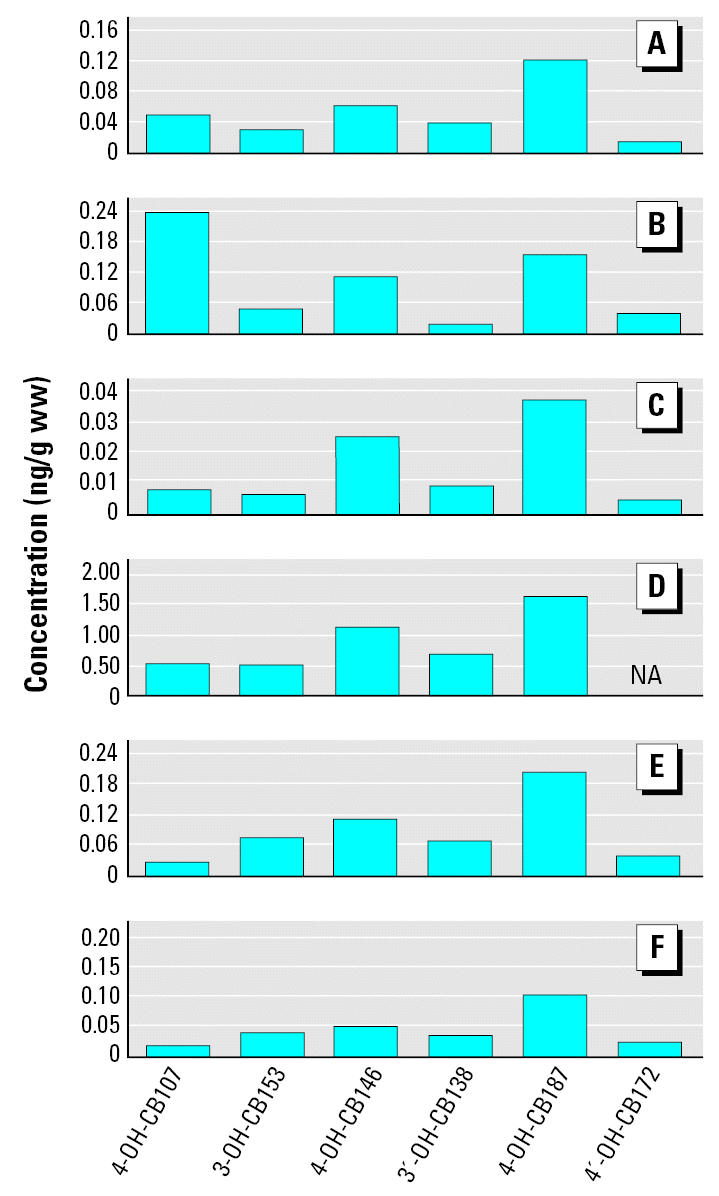
Distribution of major OH-PCB metabolites found in human blood for six regions in Europe and North America. (A) Netherlands (Soechitram et al. 2004), (B) Canadian Inuit (Sandau et al. 2000), (C) Sweden (Meironyté Guvenius et al. 2003), (D) Faroe Islands (Fängström et al. 2002), (E) Michalovce (present study), and (F) Svidnik/Stropkov (present study). NA, not available.